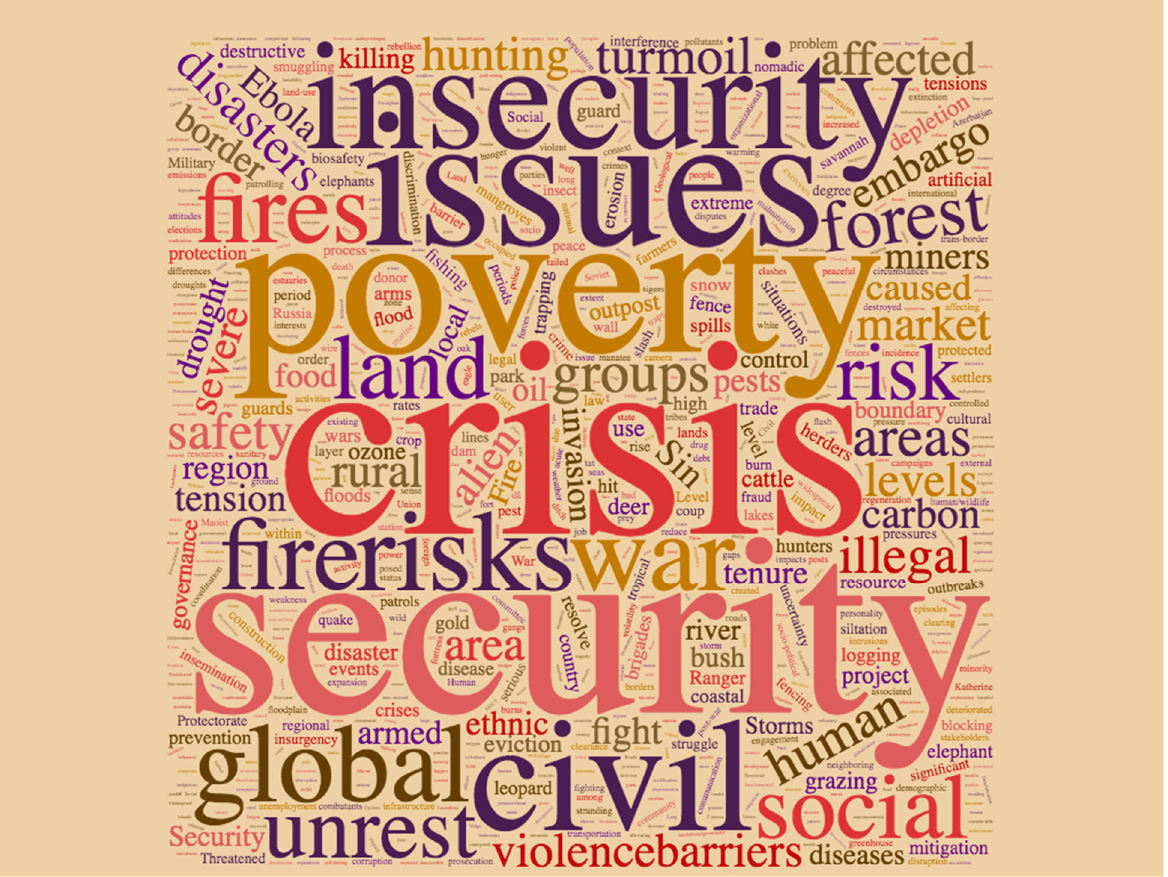
Figure 5. Wordcloud graphic produced from text entities associated with conflict in GEF biodiversity project terminal evaluations.